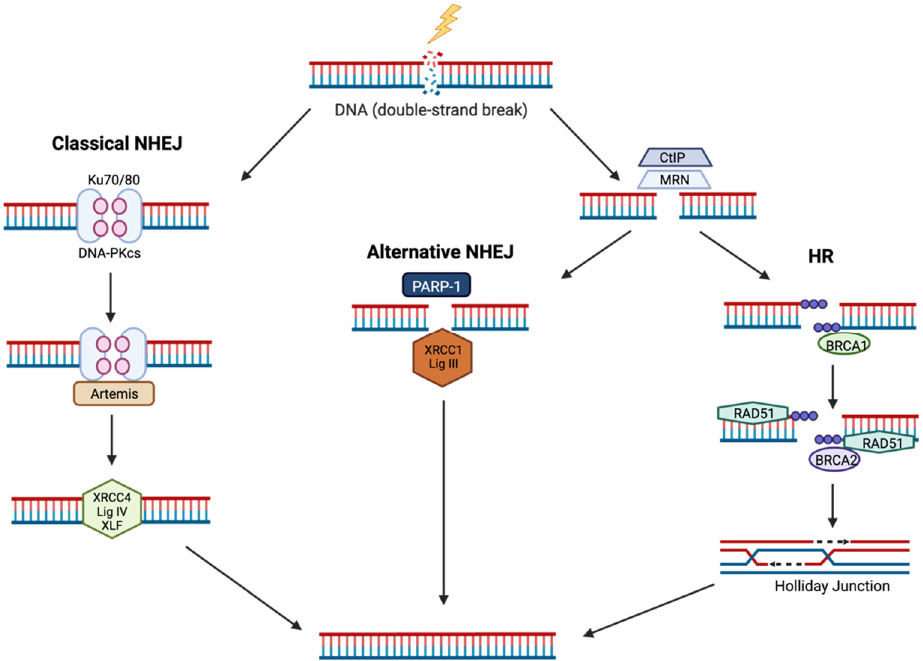
Figure 2. DSB repair mechanisms following IR. NHEJ can be divided into classical and alternative pathways, whereby classical NHEJ utilises Ku70/80 that binds to the DSB ends and recruits DNA-PKcs, Artemis and XRCC4/LIG IV to complete DNA ligation. Alternative NHEJ utilises the MRN-CtIP complex for DSB end resection following PARP-1 binding, and DNA ligation performed via XRCC1-LIG IIIα complex. During HR, DSB ends are resected via the MRN-CtIP complex and promotes BRCA1, RPA and RAD51 binding. This promotes strand invasion in a BRCA2 dependent manner, followed by the formation and resolving of Holliday junctions. Figure created with BioRender.com.